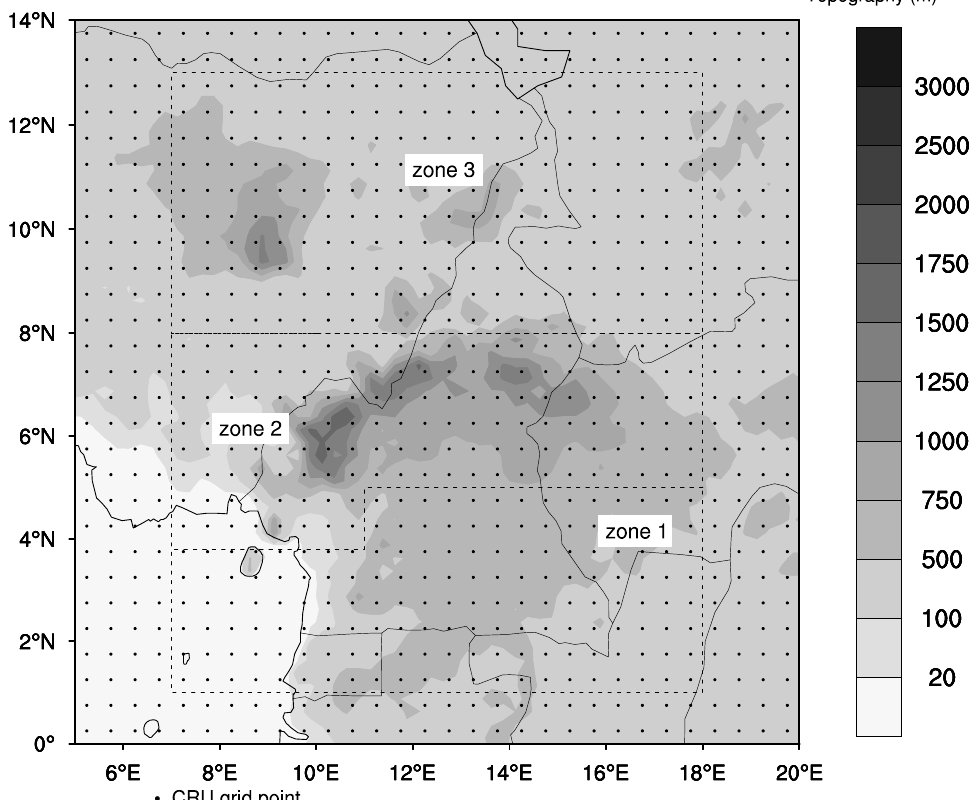
Figure 1. Study area with CRU grid points. The topography is shaded, and the area is divided into three climatic zones as classified by Guenang and Mkankam